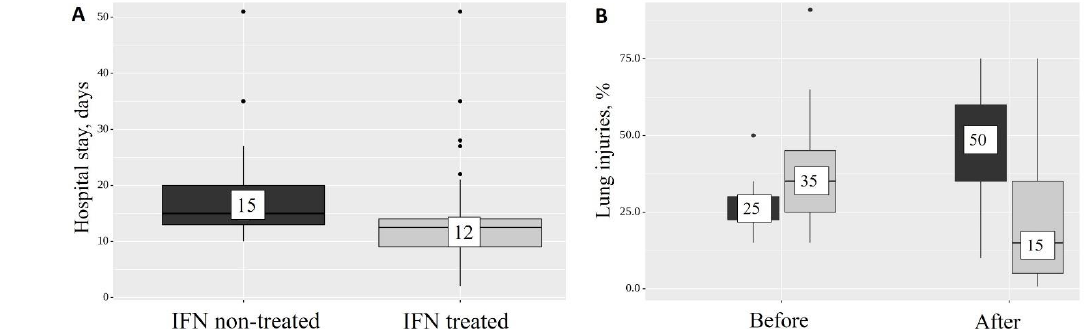
Figure 2. Treatment results. Length of hospital stay in control and treatment group ( A ), and analysis